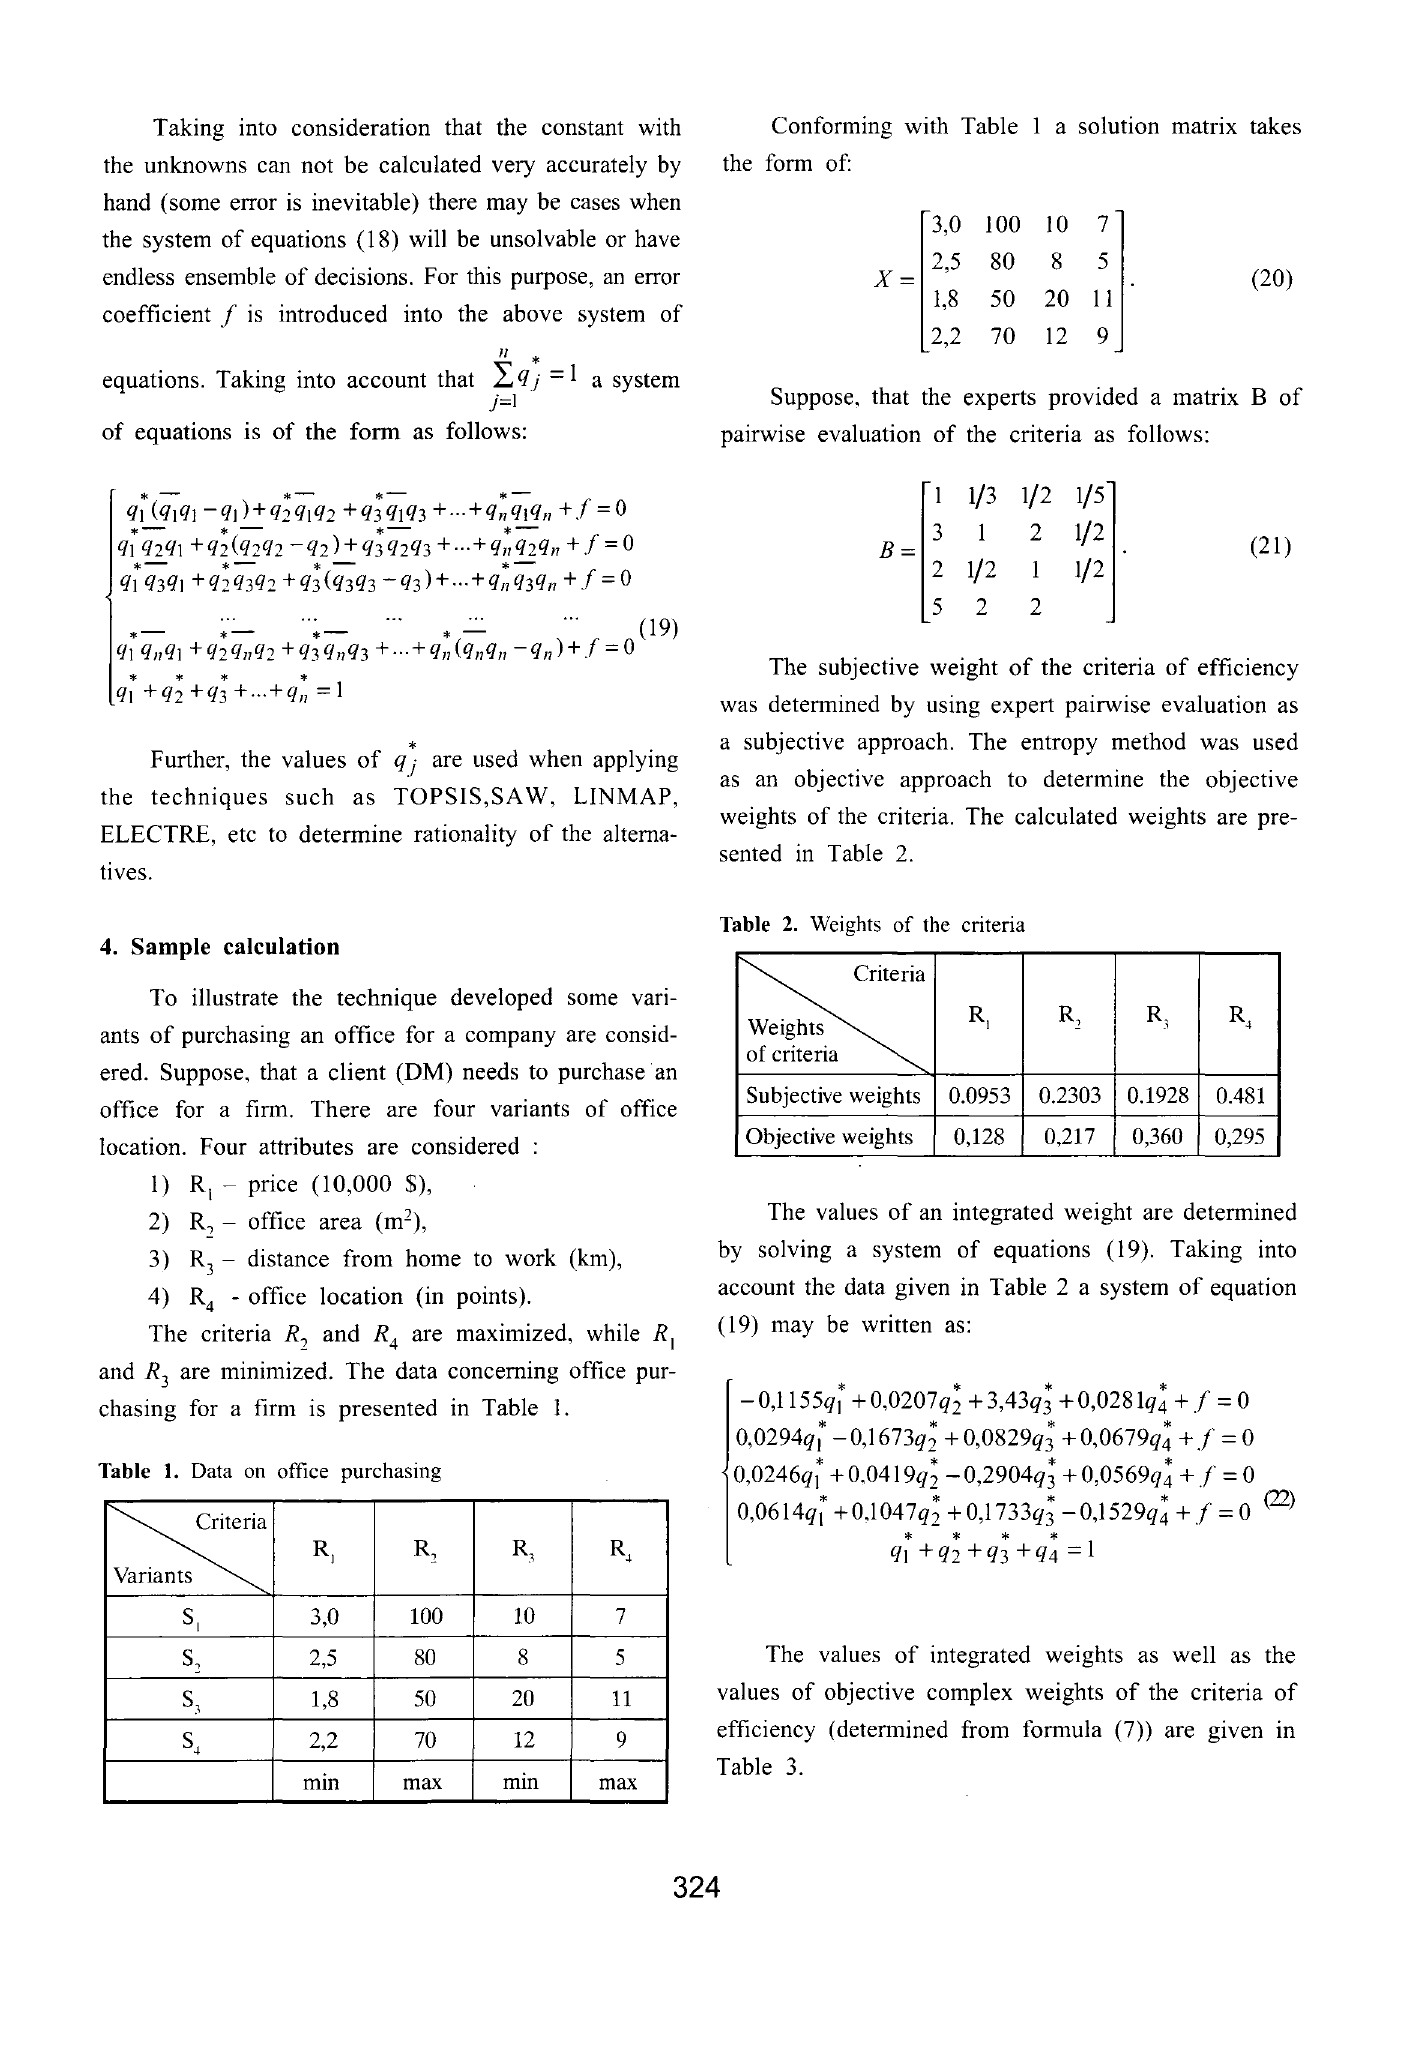
Table 1. Data on office purchasing